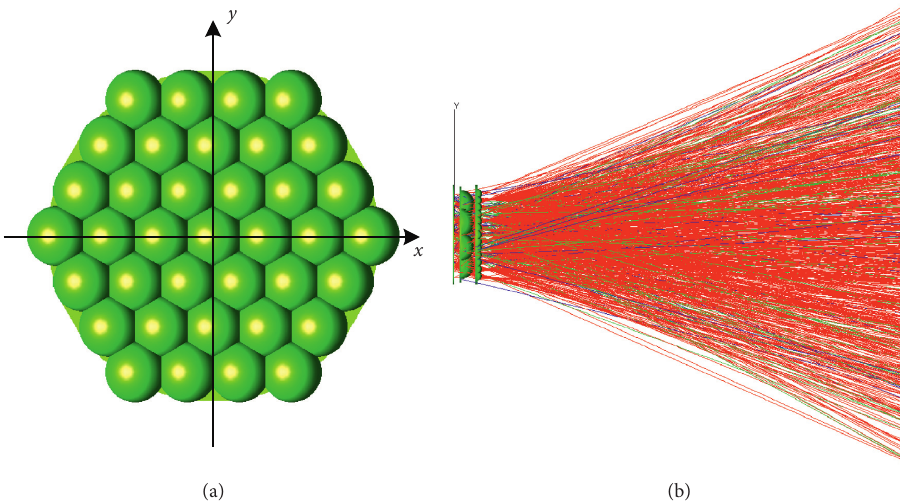
Figure 4: (a) Array structure diagram of a compound eye plano-convex lens; (b) ray-tracing renderings of the sunflower-shaped lens array and compound eye plano-convex lens.